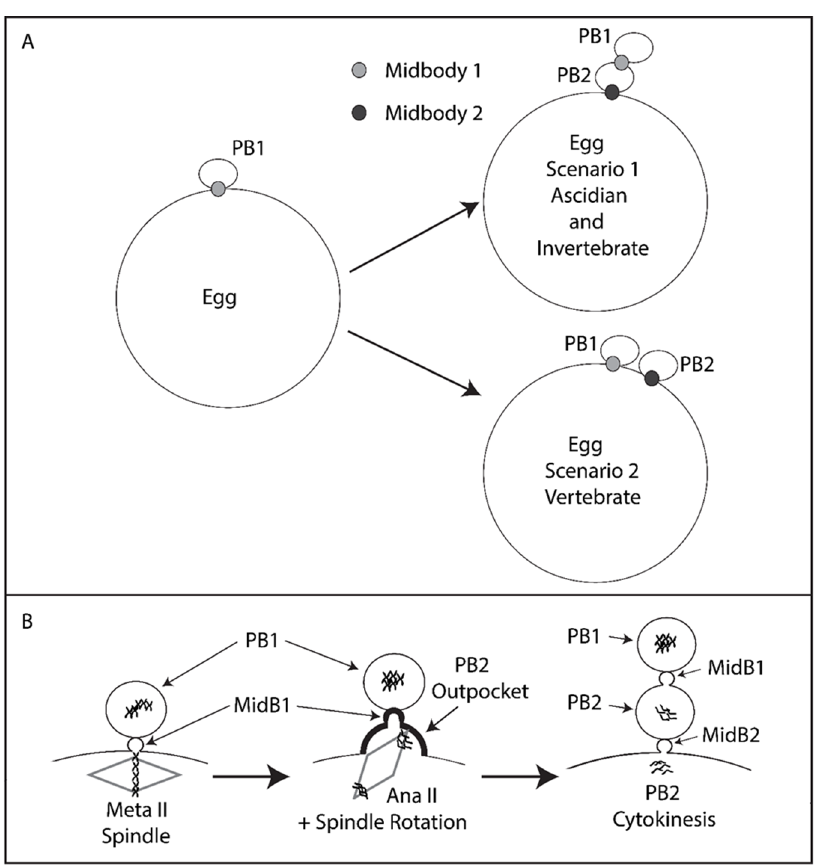
Figure 6. Model. Tethered polar bodies. ( A ) Scenario 1: tethered polar bodies. Following emission of both polar bodies, the first midbody attaches PB1 to PB2 while the second midbody links PB2 to the egg. PB1 is thus tethered to the egg indirectly via PB2. Scenario 1 represents ascidians and possibly many invertebrates (see Table 1 for details). Scenario 2: the first midbody links PB1 to the egg and the second midbody also links PB2 to the egg. Scenario 2 represents mouse and Xenopus . Midbody 1 is depicted as light grey, midbody 2 as dark grey. However, it should be stressed that midbody position is only known for certainty in the ascidian (this study). ( B ) PB2 emission dynamics. Midbody 1 is located at the apex of PB2 cortical outpocket. Spindle rotation into PB2 cortical outpocket is displayed. PB2 is emitted attached to PB1 via midbody 1 (MidB1) and PB1 is thus tethered indirectly to the egg via